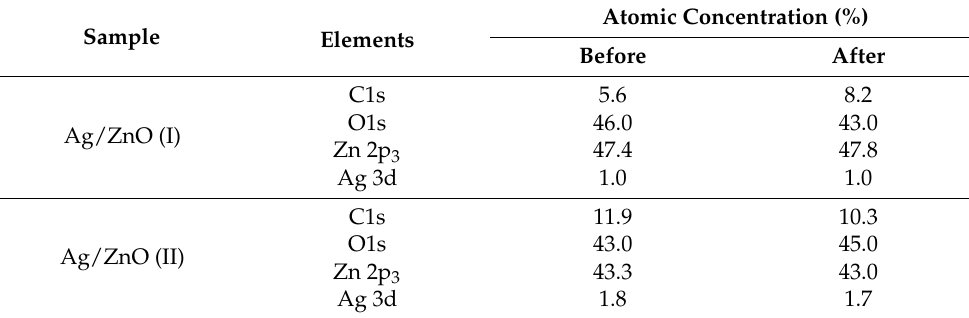
Atomic Concentration